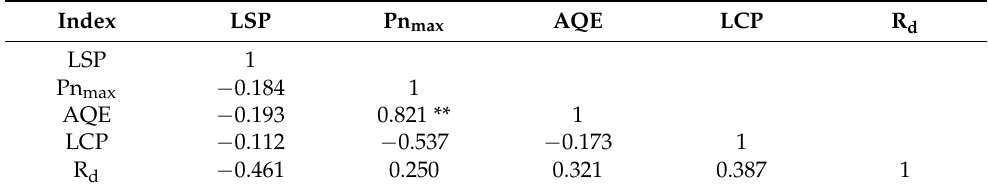
Table 4. Correlation analysis among characteristic parameters of light–response curves of Fengdanbai’ ‘Yinhongqiaodui’ and ‘Huhong cultivars of peony under high-temperature stress.